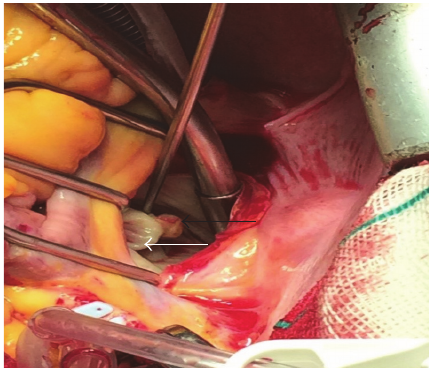
Figure 2: Intraoperative findings evidencing calcified tumor (black arrow) attached to the atrial surface of the anterior leaflet (white arrow) of the mitral valve.